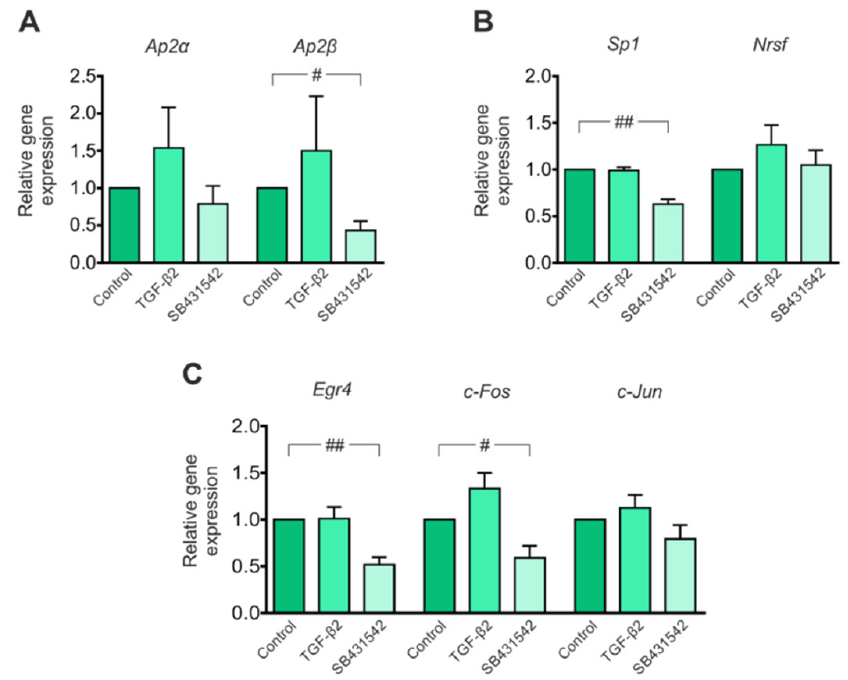
Figure 2. Regulation of expression of transcription factors with putative binding sites on the Kcc2b promoter in immature mouse hippocampal neurons by TGF- β /activin signaling. Quantitative RT-PCR analysis for the transcription factors Ap2 α , Ap2 β , ( A ) Sp1 , Nrsf, ( B ) Egr4 , c-Fos and c-Jun ( C ) on cDNA from primary immature mouse hippocampal neurons treated with either TGF- β 2 (2 ng/mL) or 10 µ M SB431542 (an ALK4, 5 and 7 inhibitor) for 60 min ( # p < 0.05 and ## p < 0.01 for significant downregulation compared to controls using the two-tailed unpaired Student’s t -test with Welch’s correction, n = 4–6). All data are shown as mean ± S.E.M. The values of the respective controls were set to